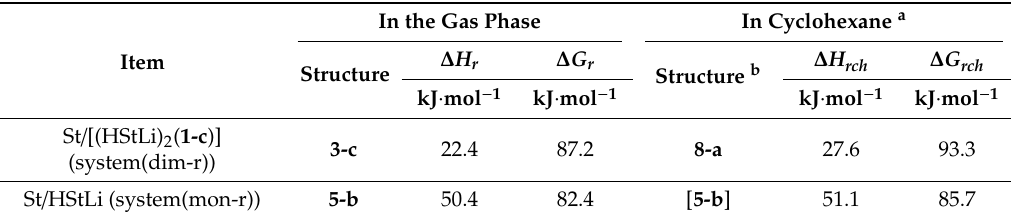
Figure 8. Optimized geometries and relative energies in cyclohexane for the transition state of St / [(HStLi) 2 ( 1-c )] with the lowest ∆ G rch , i.e., 8-a (whose structure in the gas phase is 3-c in Figure 3) and 8-b (another view of 8-a from a different aspect). The drawing details can be found in the description for Figure 2. Table 3. Relative enthalpies and free energies, respectively, in the gas phase and cyclohexane for the transition states of system(dim-r) and system(mon-r).